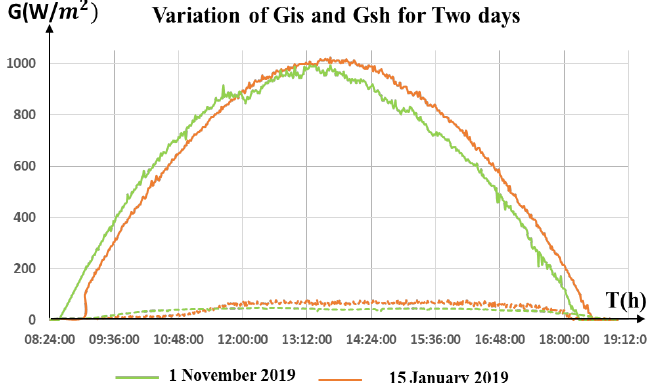
Figure 8. The variation in irradiance levels during a day in shaded and unshaded places.